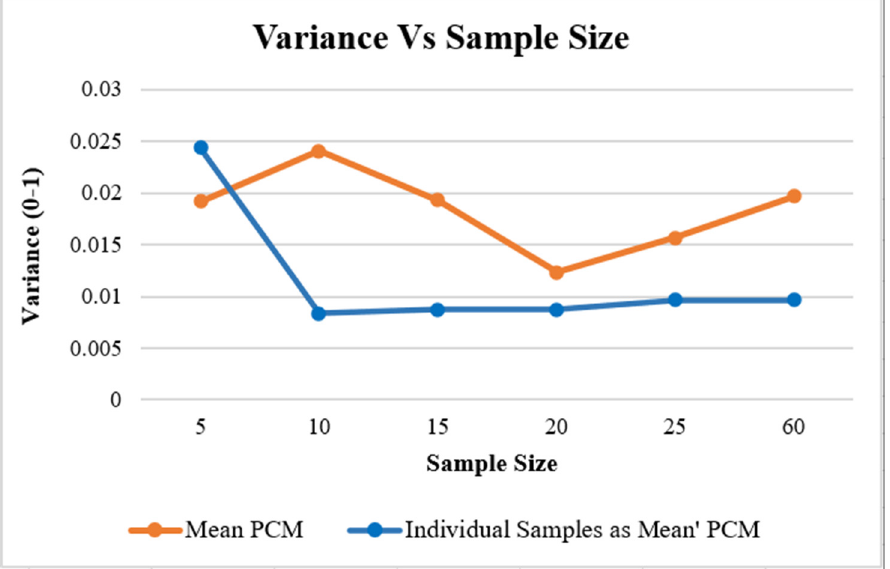
Figure 6. Graph of variance versus sample size for both the approaches.